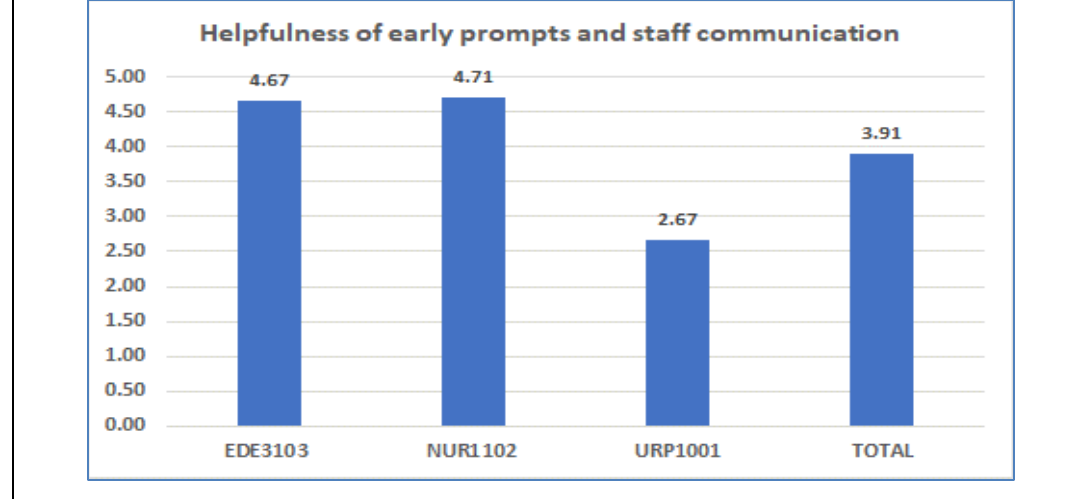
Figure 1 . Levels of student approval of the value of early prompts and